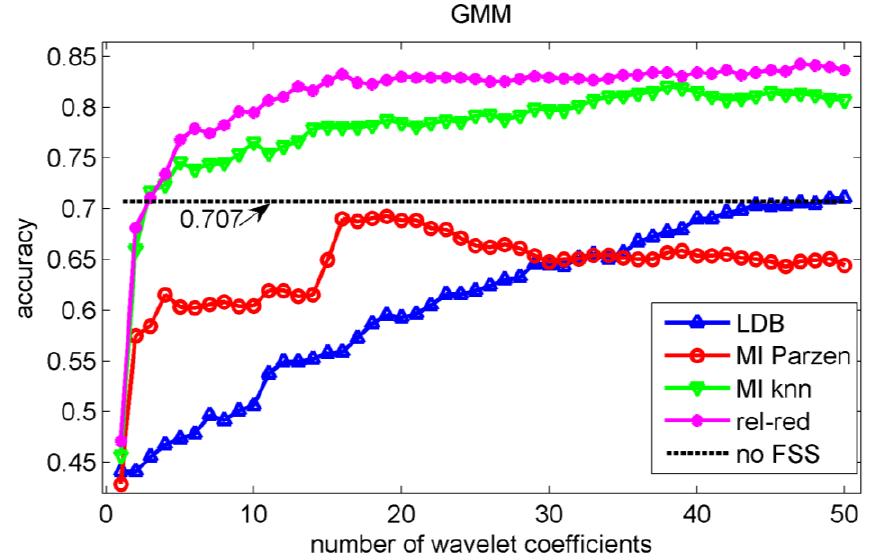
Figure 7. Evolution of the accuracy of the Gaussian mixture model as a function of the number of wavelet coefficients selected with the LDB algorithm and the mutual information filter algorithms. The horizontal line indicates the accuracy when the 1,024 samples were sub-sampled with a factor 15 to avoid numerical problems in the estimation of the parameters of the model. This subsampling was performed by taking the first time sample and then every 15th sample.